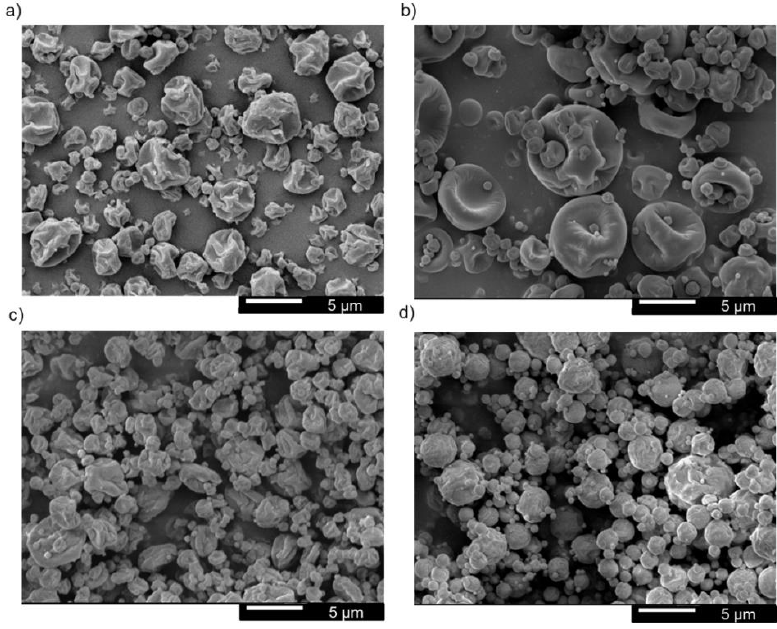
Figure 3. SEM microphotographs of 40:60 ( w / w ) itraconazole SDSDs prepared using Büchi B290 mini spray-dryer with: PVPVA ( a ), PVPK30 ( b ), HPMCAS-LF ( c ), and Eudragit L100-55 ( d ).